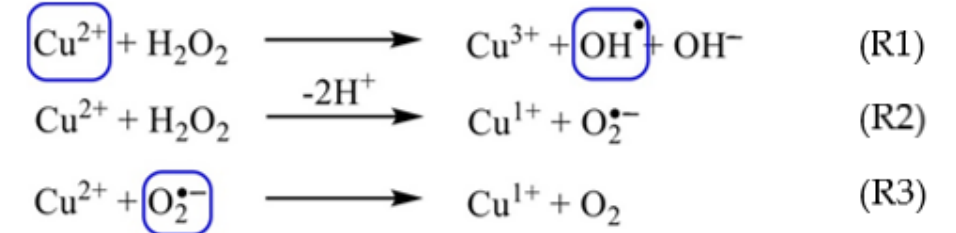
Figure 1. Reaction of copper(II) with H 2 O 2 to form OH • radicals and O 2 •− (species that are paramagnetic are marked in blue).